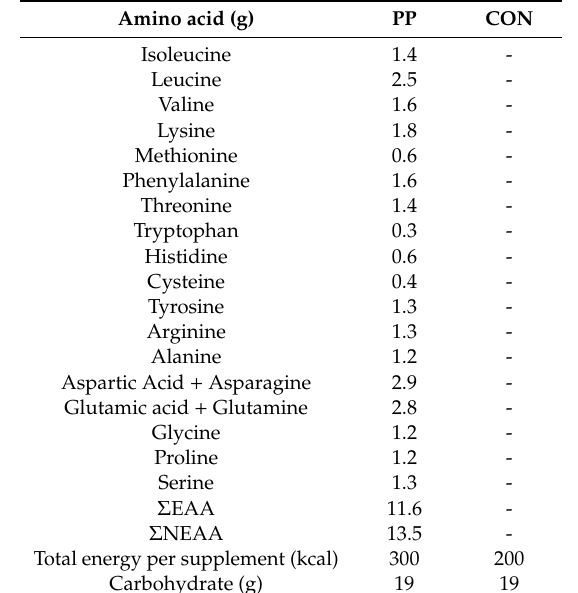
Table 1. Amino acid composition of the potato protein (PP) supplement (25 g / serving) and energy intake of PP and control (CON)